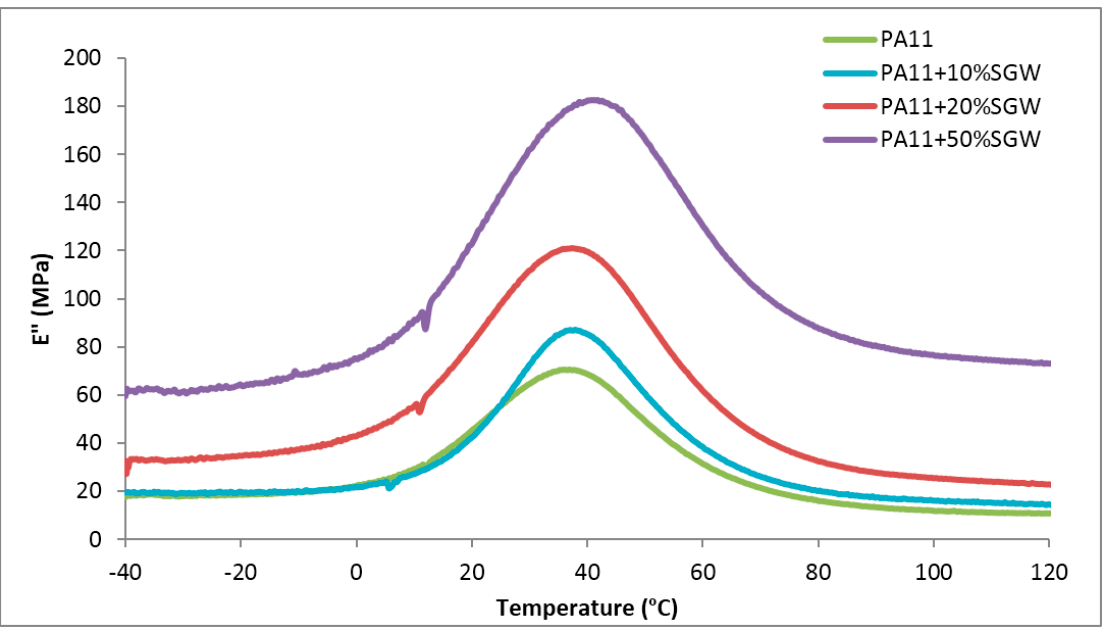
Figure 3. Loss Modulus of the PA11, PA11 + 20% SGW and PA11 + 50% SGW with respect to the temperature.